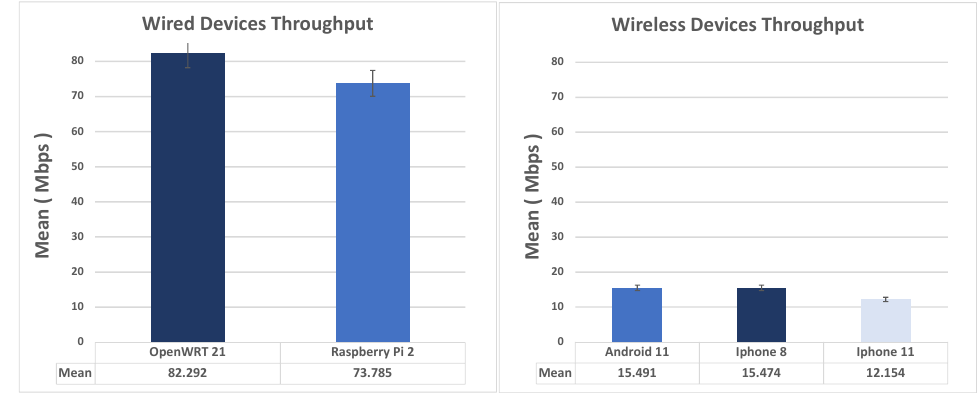
Figure 9. Comparison of the average Throughput in IPsec IKEv2 X509 Road Warriors scenario.